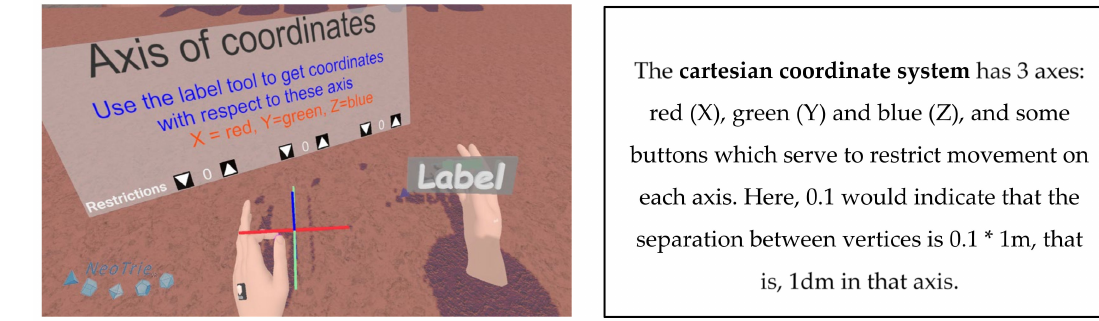
Figure 4. The labeling tool and the 3D axis system.